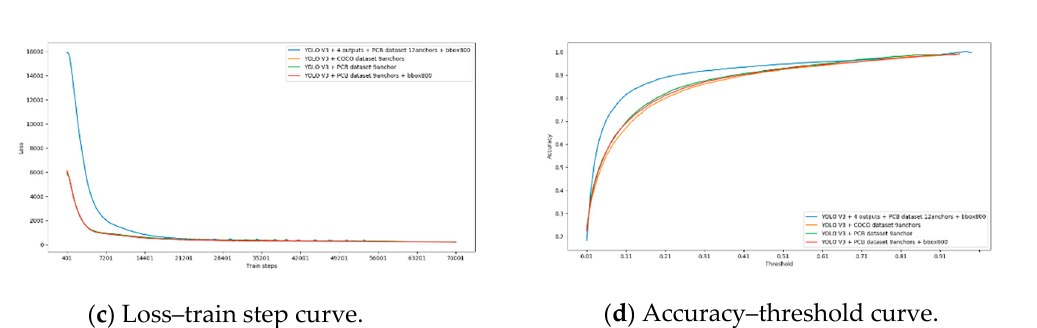
Figure 13. Evaluation curves of the four algorithms.